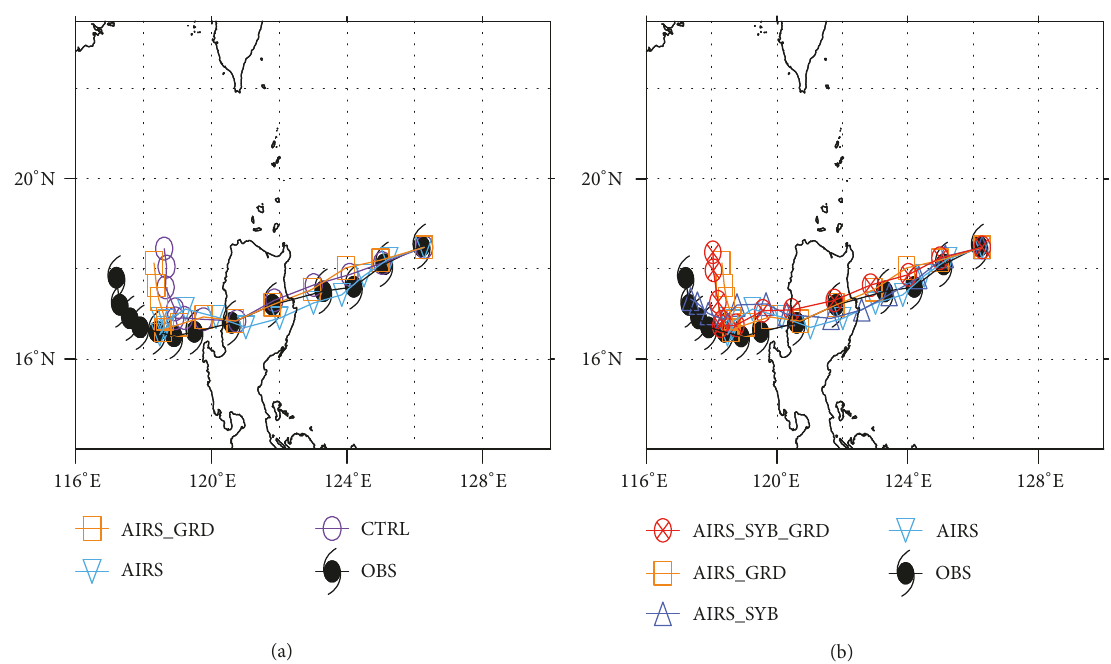
Figure 4: Tracks of TC from experiments and best track provided by CMA-STI (OBS) (with (a) and without the systematic bias (b)).